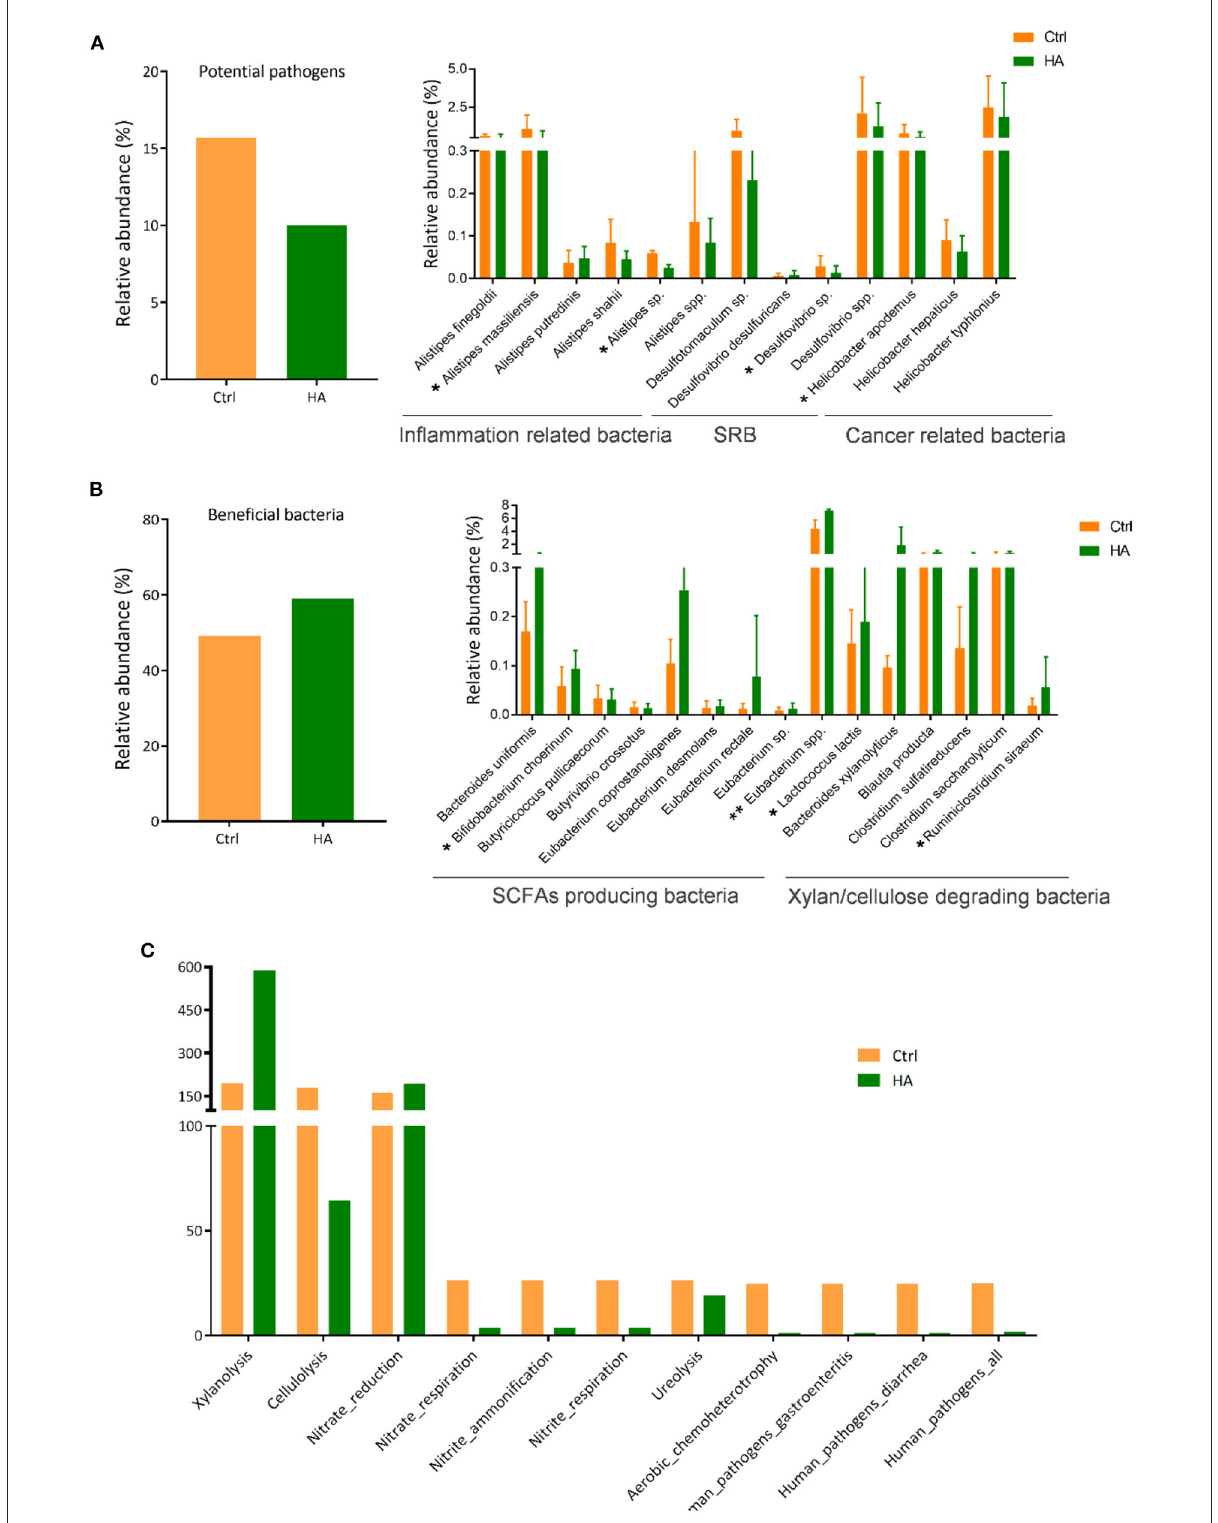
FIGURE3 HA altered the relative abundance of the potential pathogens and beneficial bacteria in the experimental mice. (A) The total OTU of potential pathogens of the control and HA-treated mice. (B) The total OTU of beneficial bacteria of the control and HA-treated mice. SRB, sulfate-reducing bacteria. SCFAs, short-chain fatty acids. (C) The results of FAPROTAX functional prediction of GM in the control and HA groups. SRB, sulfate-reducing bacteria. n = 5. * p < 0.05; ** p <